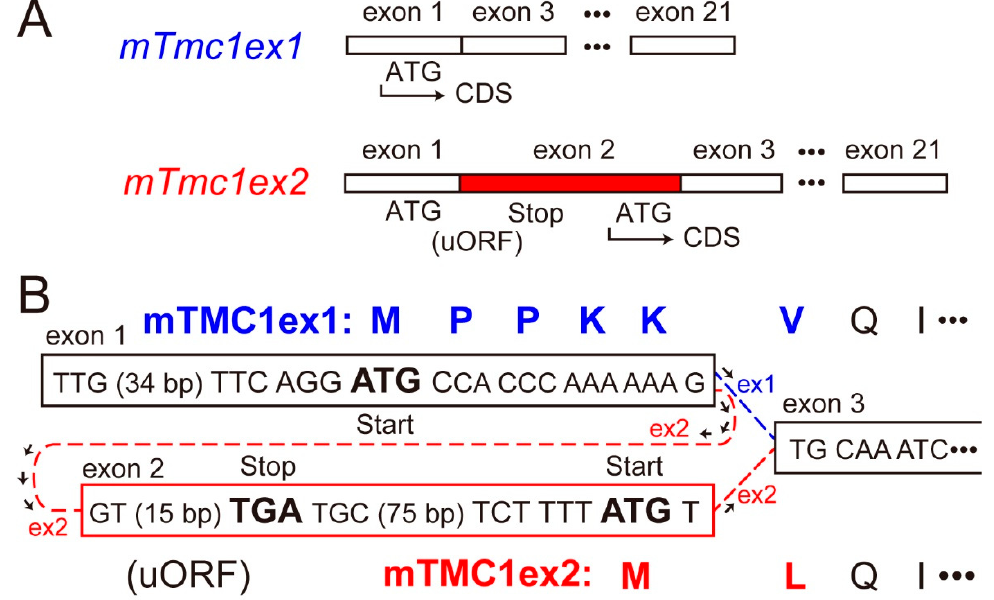
Figure 1. Di ff erences in the splice variants of mouse Tmc1 ( mTmc1 ) and their translated Figure 1. Differences in the splice variants of mouse Tmc1 ( mTmc1 ) and their translated proteins: ( A ) the exons which form mRNA of mTmc1 splice variants, mTmc1ex1 and mTmc1ex2 . Exons 4–20 are omitted. The difference between mTmc1ex1 and mTmc1ex2 is the absence and presence of exon 2 in